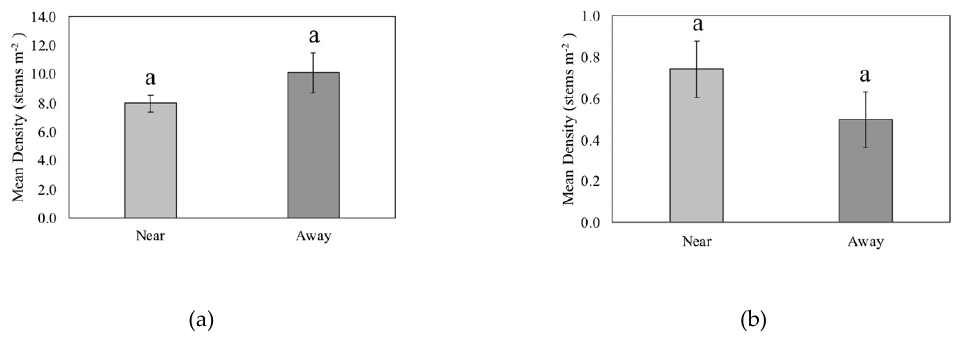
Figure 3. Mean density of ( a ) seedlings (live woody stems <1 m height) and ( b ) saplings (live woody stems ≥ 1 m height, <5 cm dbh) of quadrats located near and away from coarse woody debris (CWD) in a Pinus palustris woodland following catastrophic disturbance. No significant differences ( p < 0.05) were found.